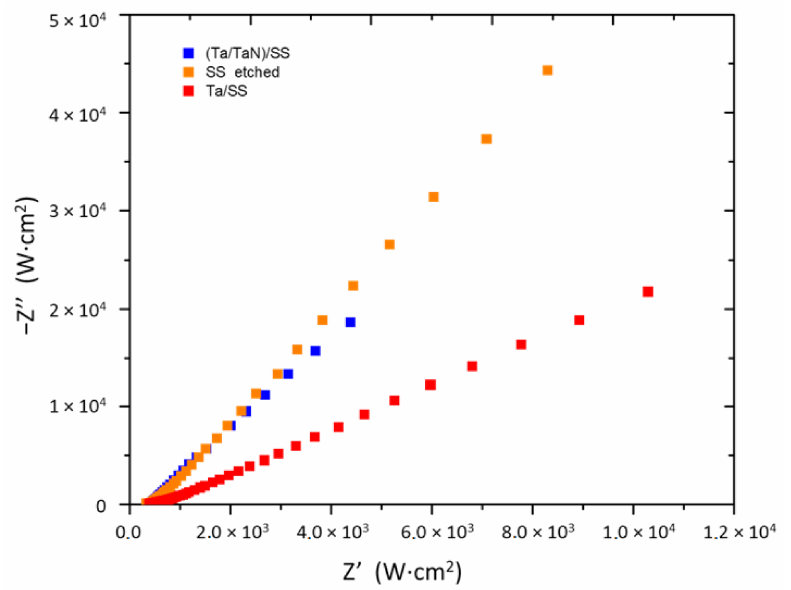
Figure 1. Nyquist diagram of stainless steel substrates of the following types: etched SS, Ta/SS coating, and (Ta/TaN)/SS.